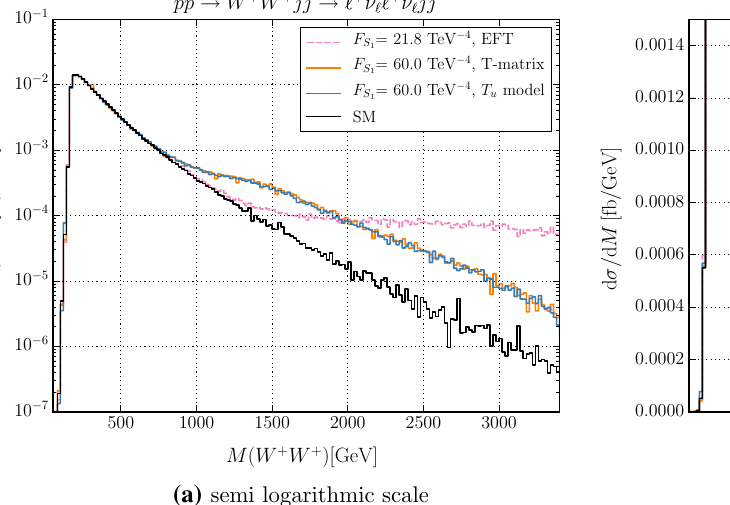
Fig. 4 Comparison of T u model and linear T-matrix unitarization. Dif- ferential cross section as a function of the invariant mass m WW of the weak vector bosons for pp → (cid:6) + ν (cid:6) (cid:6) + ν (cid:6) jjX . The solid black line showstheSM,whilethedashedpinklineshowsthecrosssectionforthe